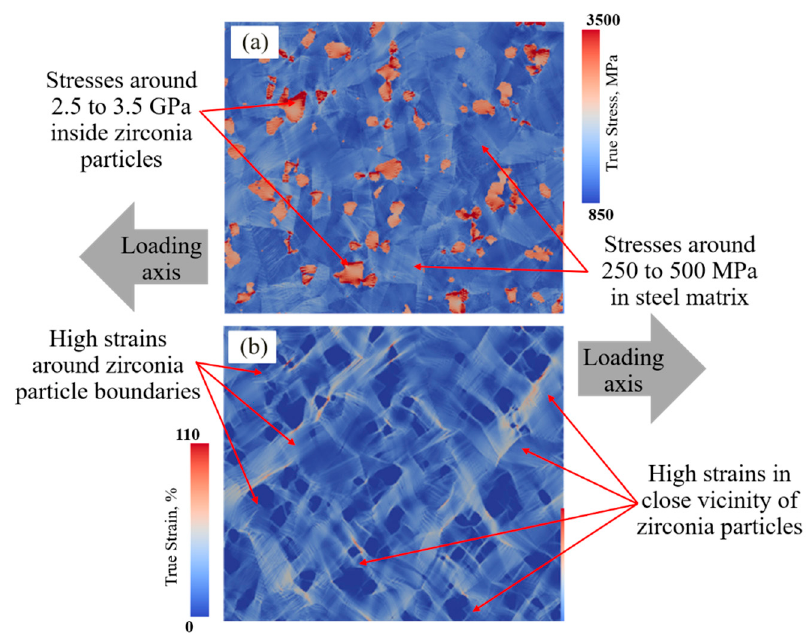
Figure 10. Visualization of 10% MMC simulation local results for the last frame: ( a ) local von Mises–Cauchy stress in different phases; and ( b ) local von Mises logarithmic strain in different phases. The local stress map at the final frame of the simulation is presented in Figure